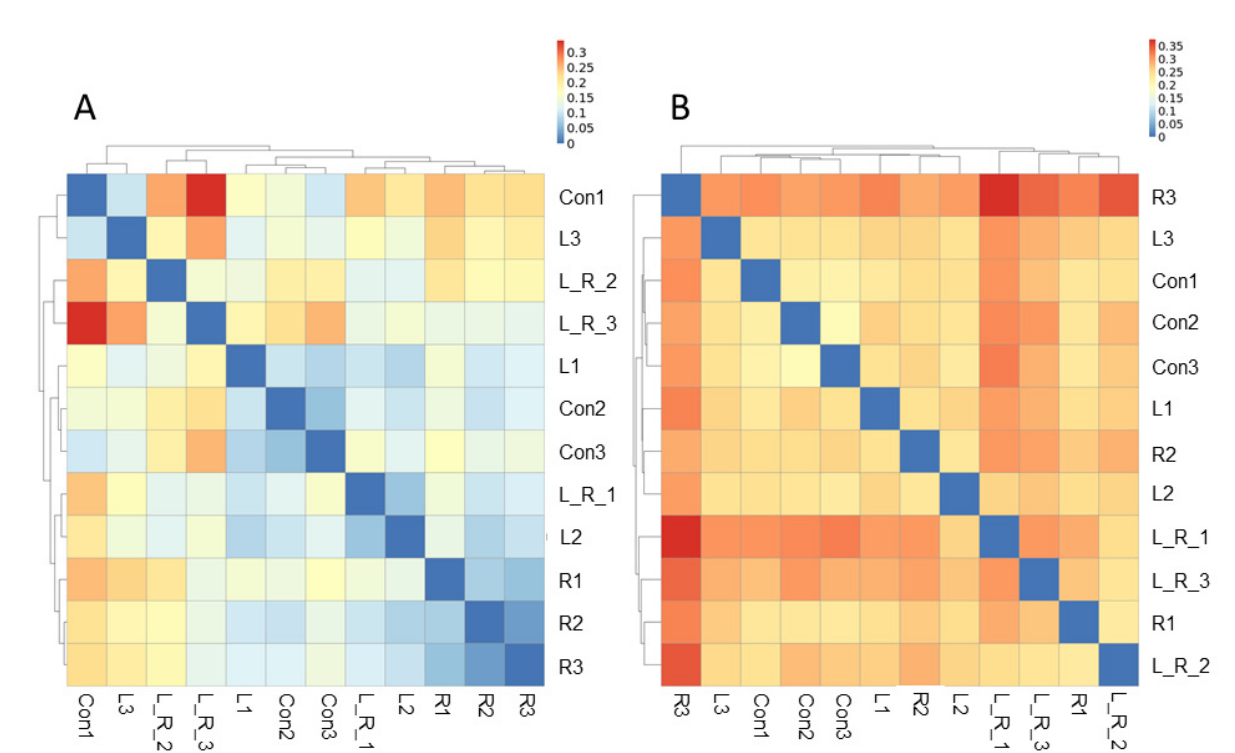
Figure 4. Comparative heat map analysis of the cecum contents. ( A ) The beta diversity index of the cecum content from the basal diet (Con), control plus 0.6% Hydrastis canadensis root (R), control plus 0.6% Hydrastis canadensis leaf (L), control plus 0.6% Hydrastis canadensis root and leaf (LR) on weighted UniFrac metrics. ( B ) The beta diversity index of the cecum content from Con, R, L, and LR on unweighted UniFrac metrics.